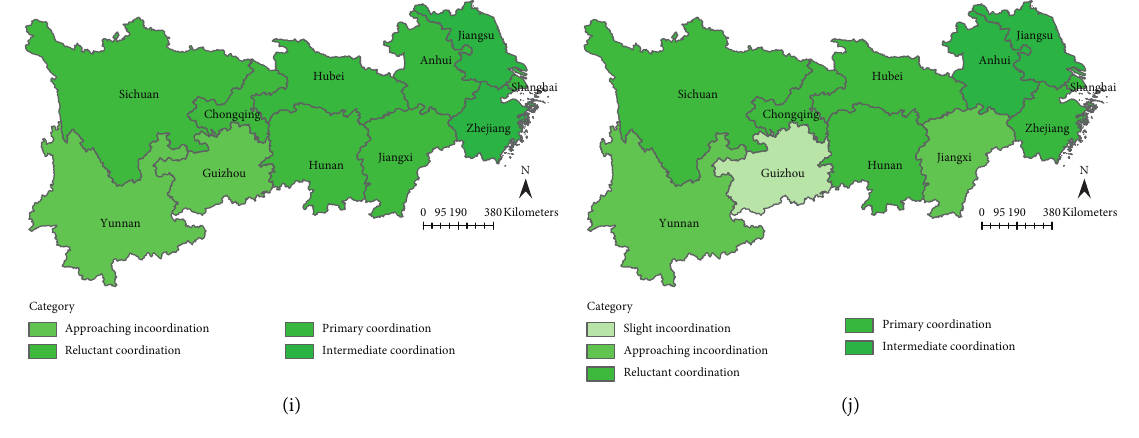
Figure 6: Spatial distributions of the CCD. (a–j) 2009–2018. Table 7: Prediction of the